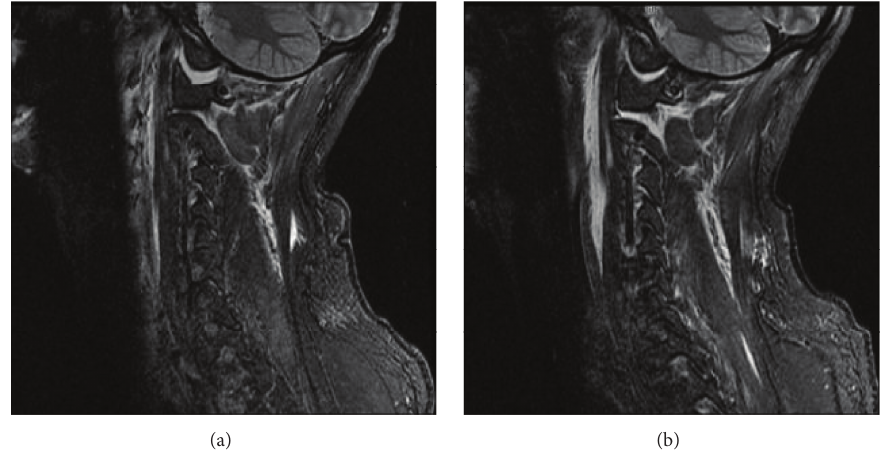
Figure 7: Left and right parasagittal STIR weighted MRI showing displaced occiput-C1 joints.